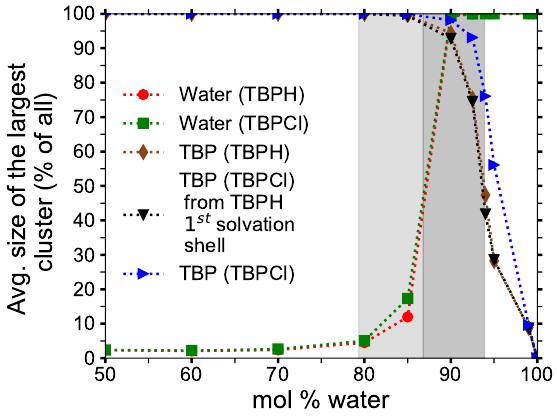
Figure 7. Clustering data for water and TBP + ions at 300K.